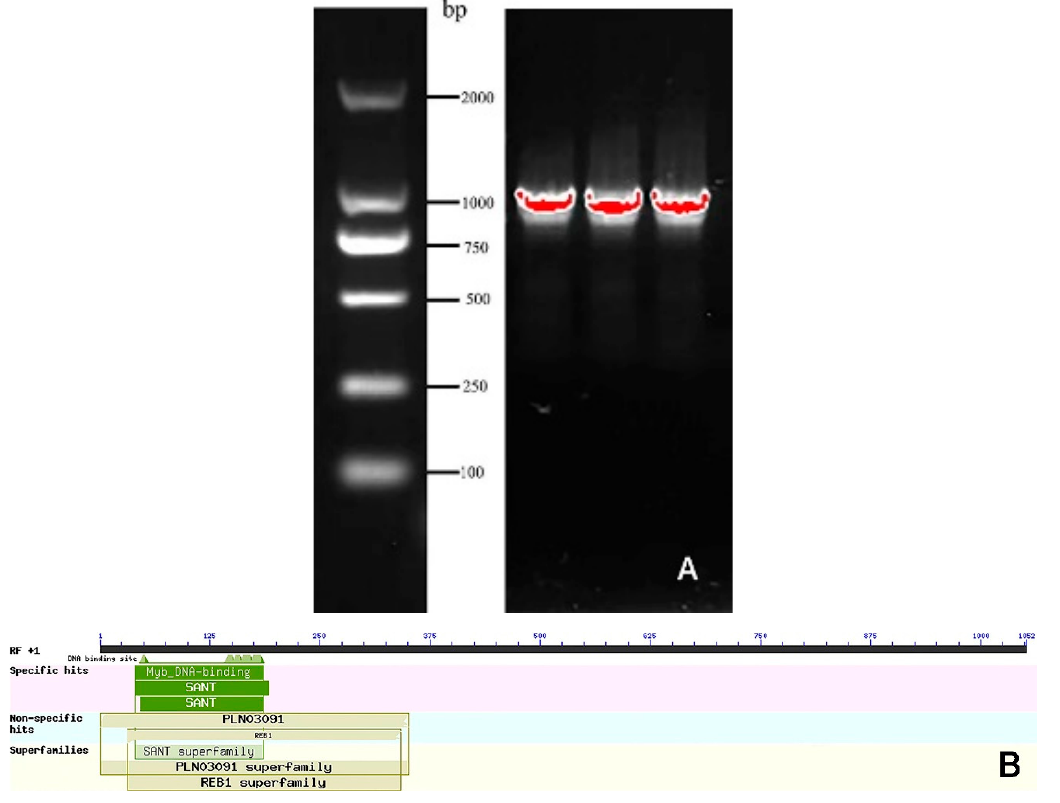
Figure 1. ( A ) Gene cloning figure. ( B ) Conservative domain analysis.